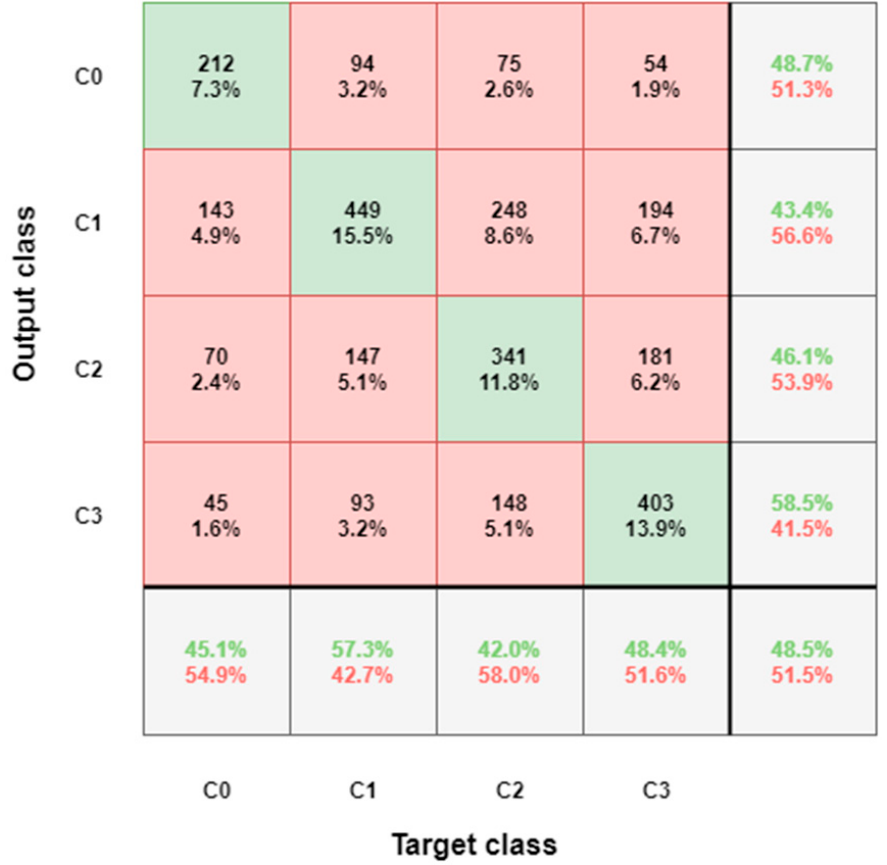
Figure 10. Confusion matrix for four conditions discrimination (classes 0, 1, 2, 3). Overall, an accuracy of 48.4% almost doubles the random guess baseline (25%) and the confusion between neighboring classes is higher than between more distinct ones.